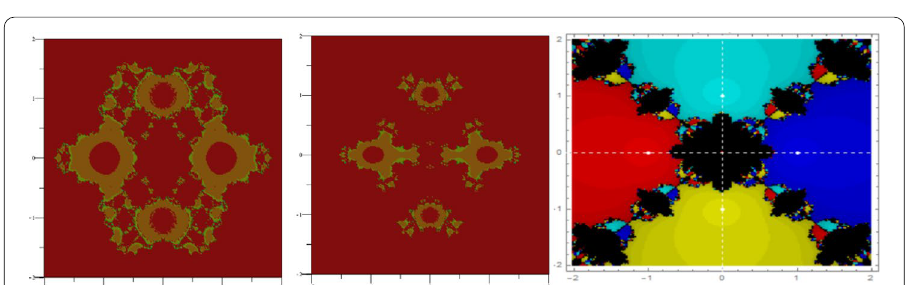
Fig. 9 Plots of 8th BM for θ = 0.5 , θ = 1 and the method in CMB [19] respectively for g 4 ( z ) .